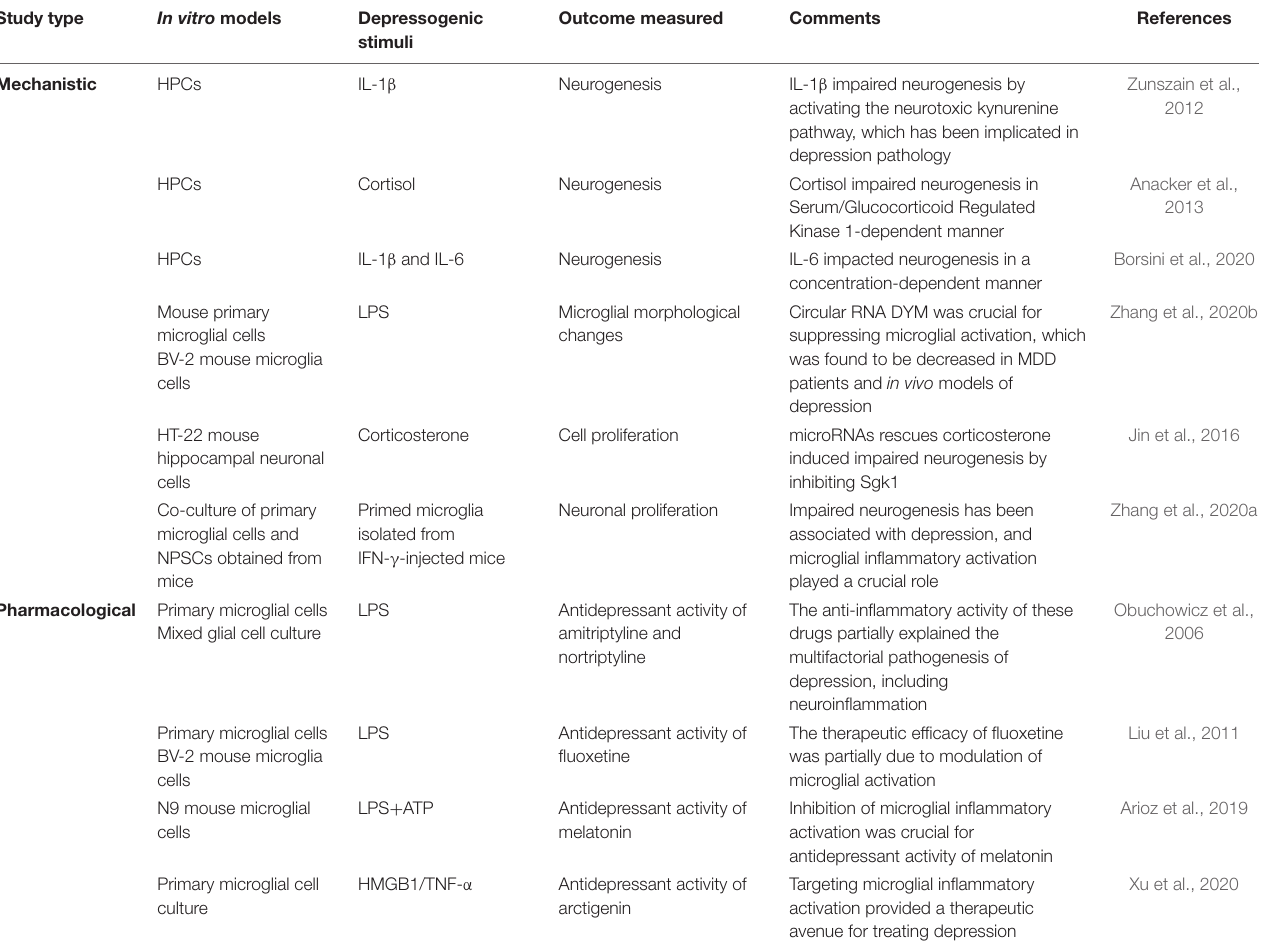
TABLE 2 | Experimental findings in in vitro model of